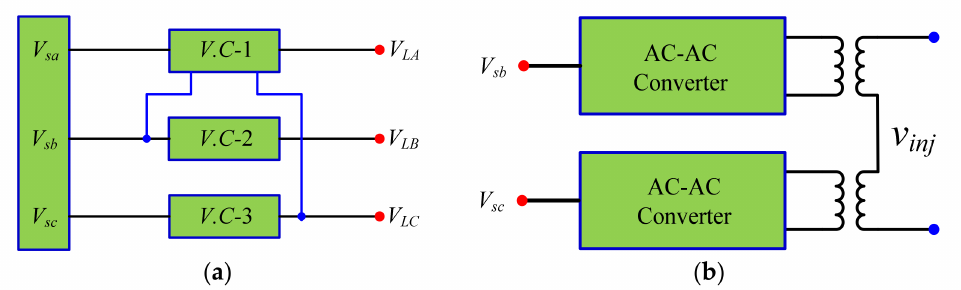
Figure 3. ( a ) Voltage compensation through interphase connection; ( b ) interconnection of AC-AC converters.